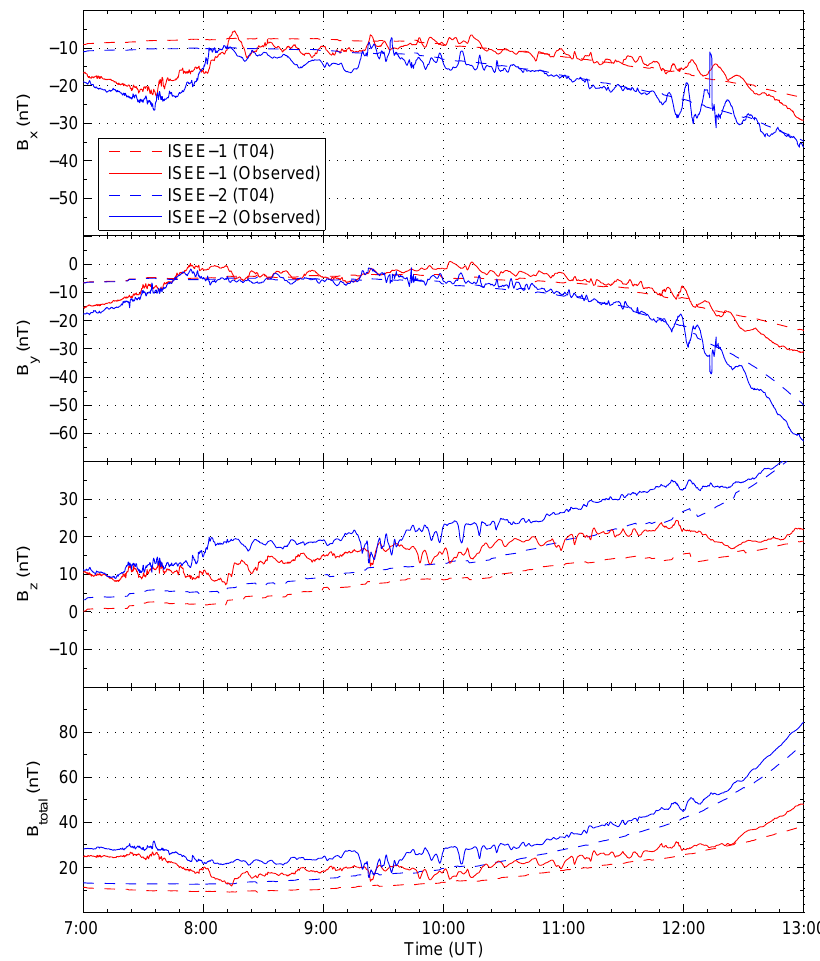
Fig. 10. Local magnetic field (B X , B Y , B Z , and B T ) data recorded by the magnetometer onboard ISEE-1 (red solid line) and ISEE-2 (blue solid line) and modeled by the T04 geomagnetic field model at ISEE-1 (red dashed line) and ISEE-2 (blue dashed line) locations during 07:00–13:00 UT on 3 March